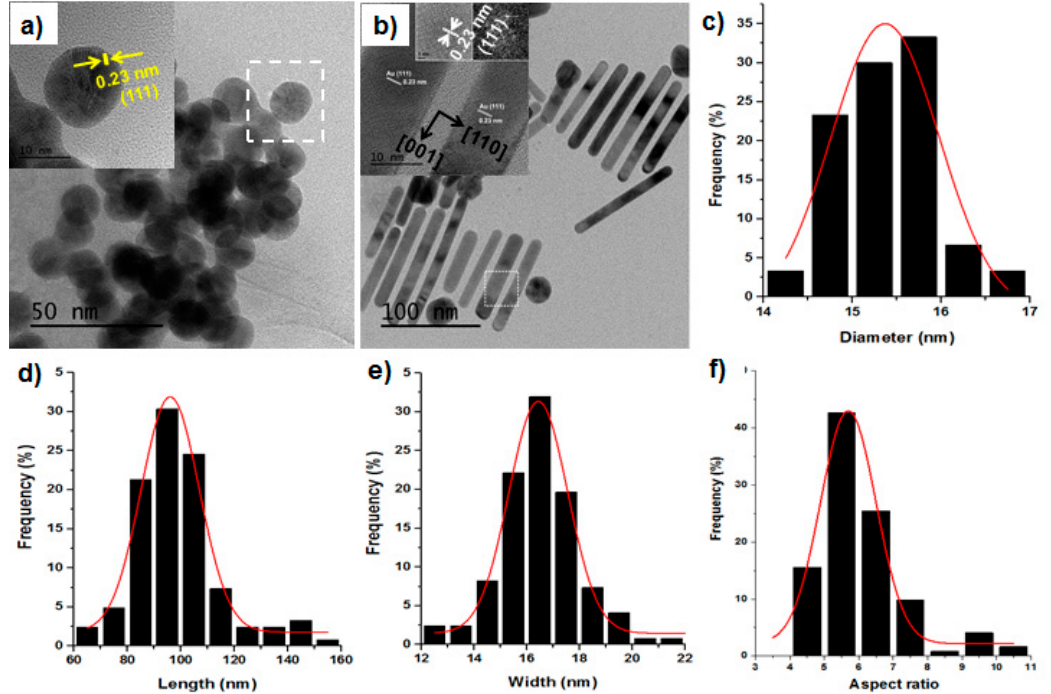
Figure 4. Transmission electron microscopy (TEM) images of ( a ) Au nanoseeds and ( b ) AuNRs. The insets: High resolution transmission electron microscopy (HRTEM) images of ( a ) Au nanoseeds and ( b ) AuNRs. Particle size distribution of ( c ) Au nanoseeds, and ( d , e ) AuNRs. ( f ) Aspect ratio of AuNRs.